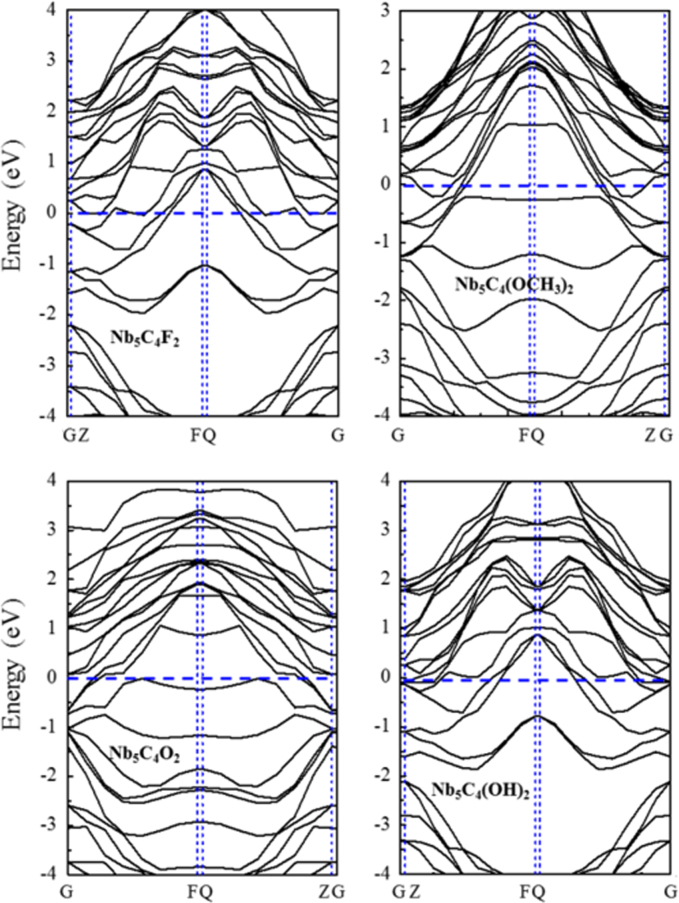
Band structures of Nb5C4Z2 (Z = F, O, OH, OCH3).